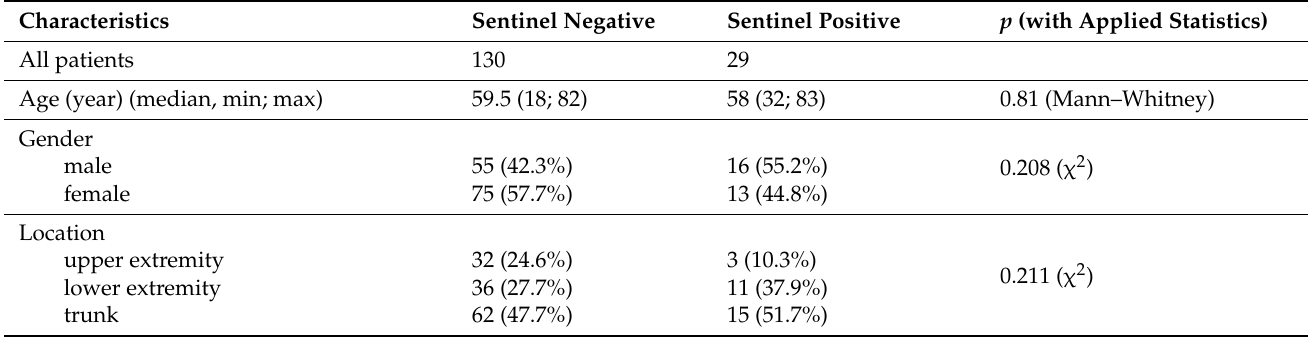
Table 2. Distributional differences of melanoma patients by sentinel lymph node